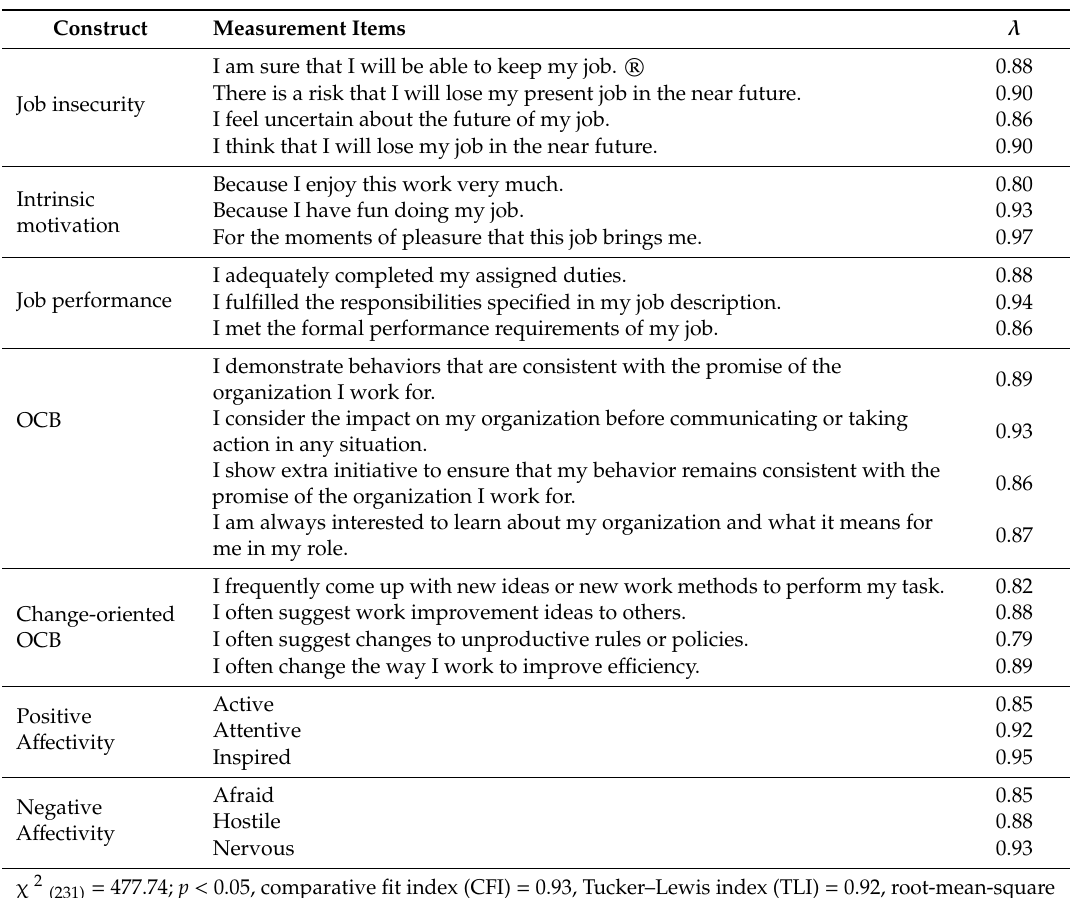
Table 1. Factor Analytic Results of Measurement